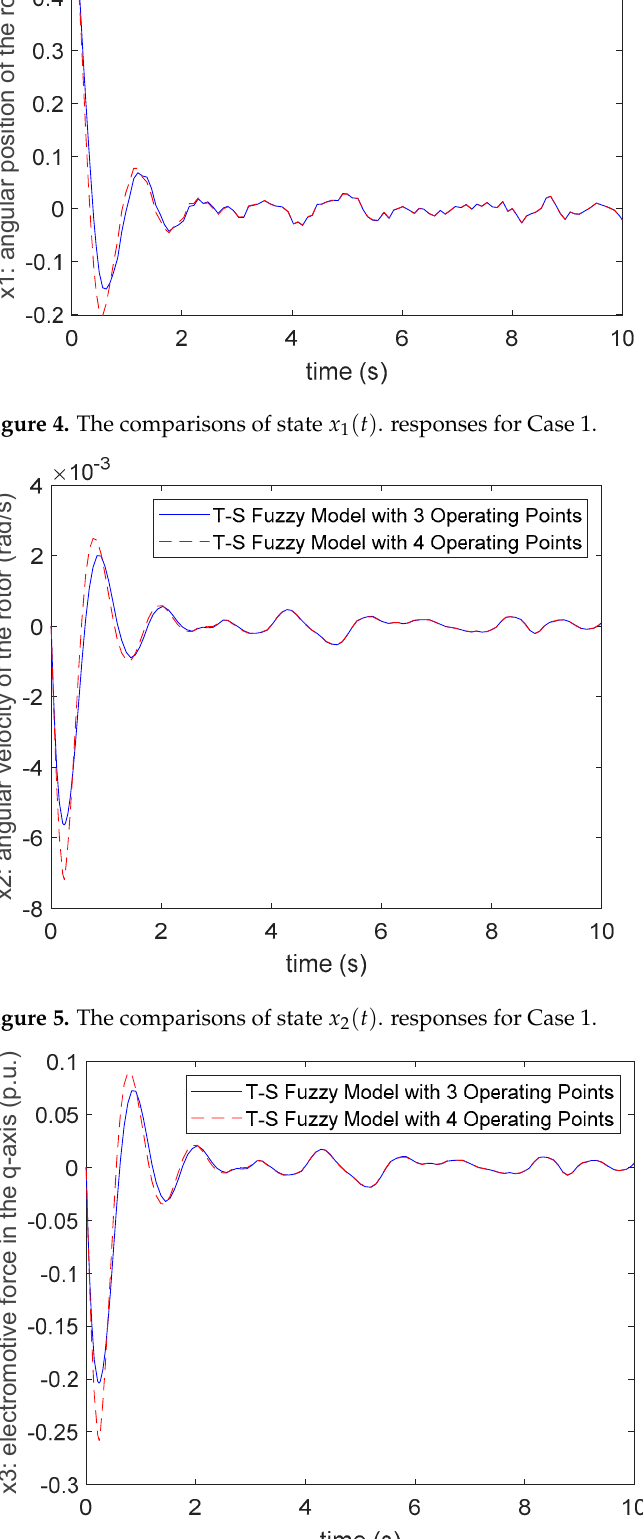
Figure 6. The comparisons of state x 3 ( t ) . responses for Case